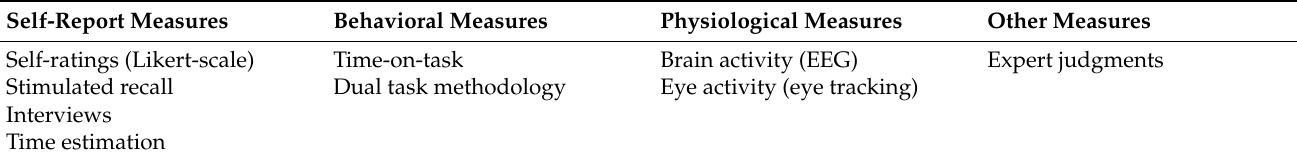
Table 4. Measures of cognitive load in writing